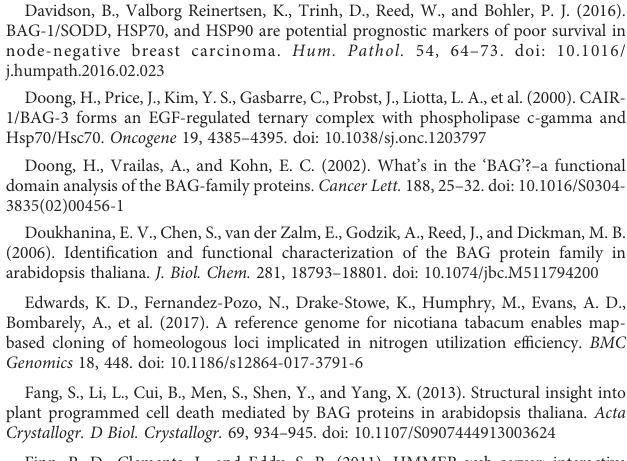
SUPPLEMENTARY FIGURE 1 Cis -acting elements on promoters (1500 bp) of NtBAG genes. The number shows the number of cis -acting elements.